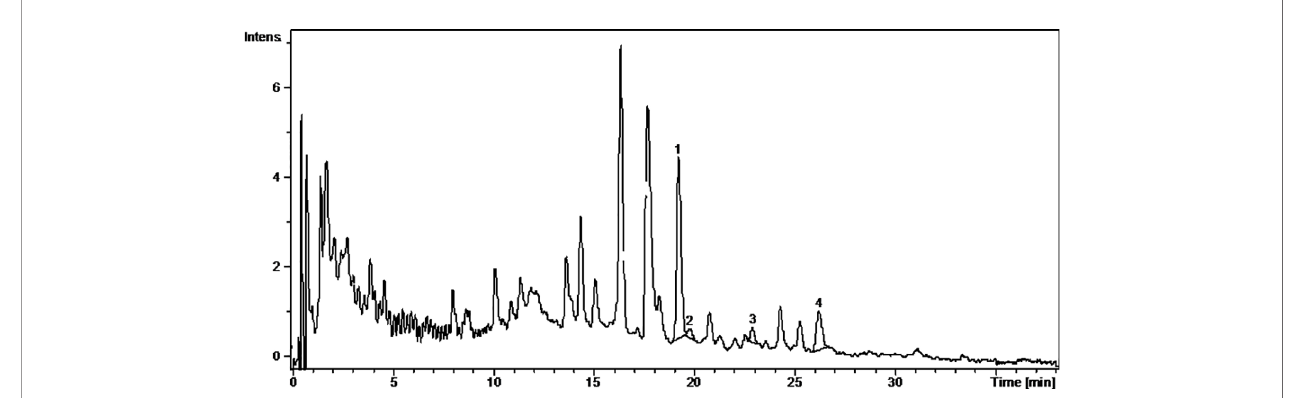
FIGURE 1 | The UV chromatogram of fresh Pinot noir 2015 grape pomace extract. 1, Isoquercitrin; 2, Rutoside; 3, Quercitrin; 4, Quercetin.